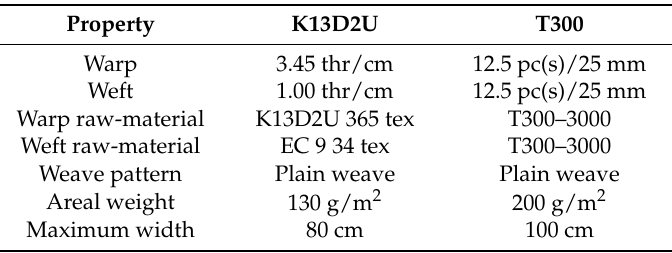
Table 4. Nominal properties of carbon fiber fabrics used.